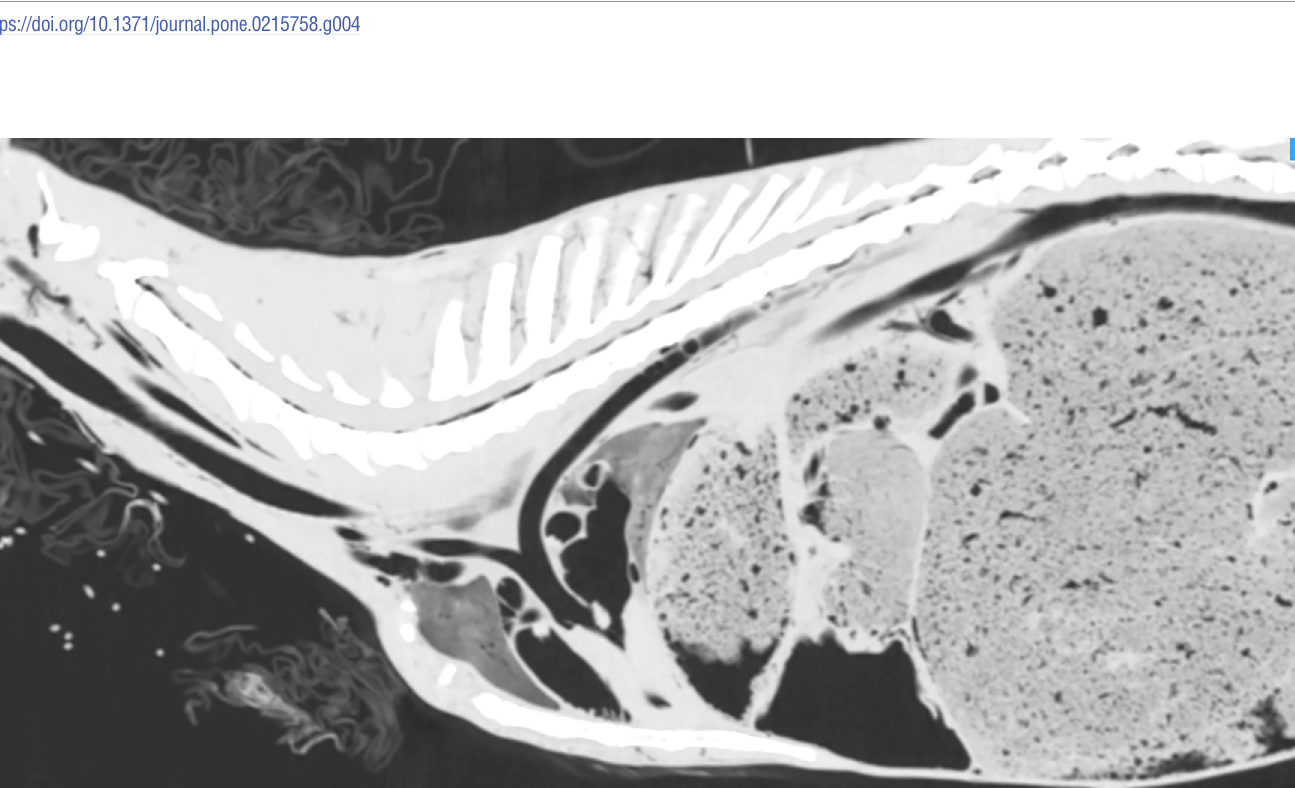
PLOS ONE | https://doi.org/10.1371/journal.pone.0215758 April 23,